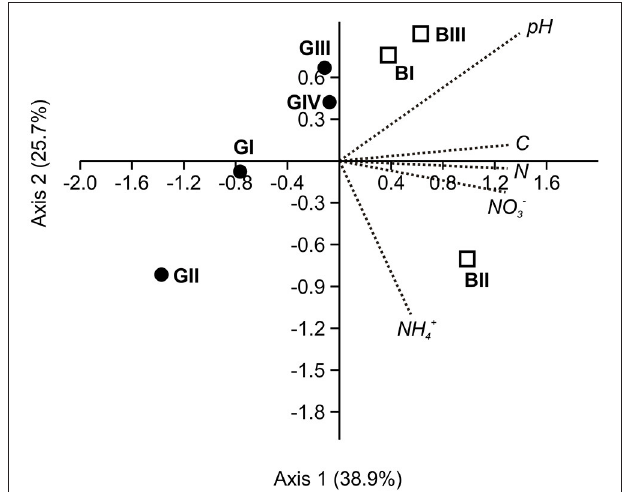
FIGURE 4 | Biplot from canonical correspondence analysis (CCA) of five measured environmental variables (ammonium concentration, nitrate concentration, total C, total N, soil pH) and the bacterial 16S rRNA gene-based community structure in soil samples from two catenas, detected as average read numbers of OTUs determined at 97% sequence identity on nucleic acid-level per sampling location. For this purpose, samples were normalized to the same number of total reads prior to analysis. Samples from the granitic and the basaltic catena are shown as filled circles (GI-GIV) and open squares (BI-BIII),